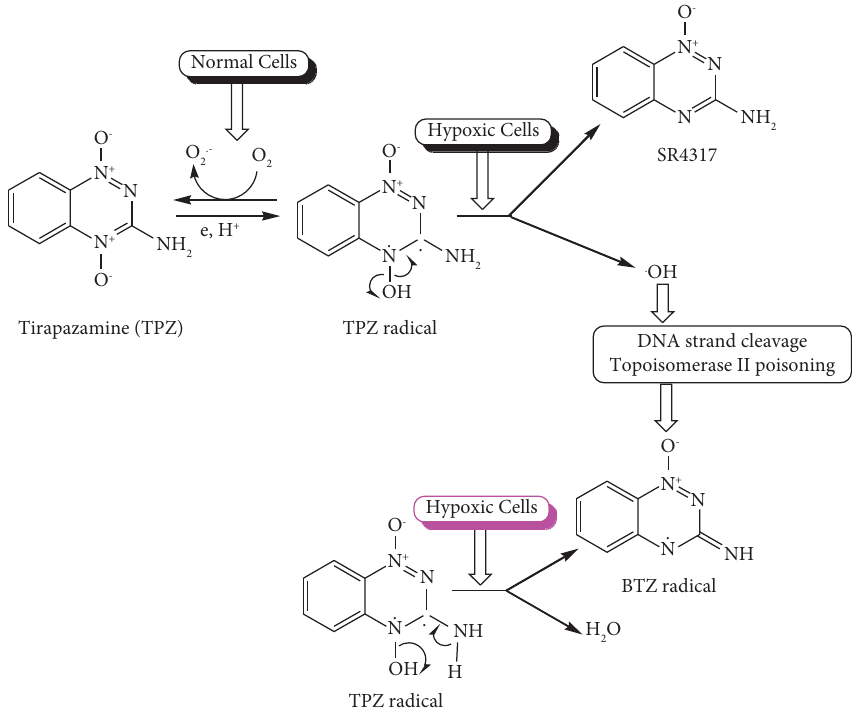
Figure 5: Summary mechanism of tripazamine under normal and hypoxic